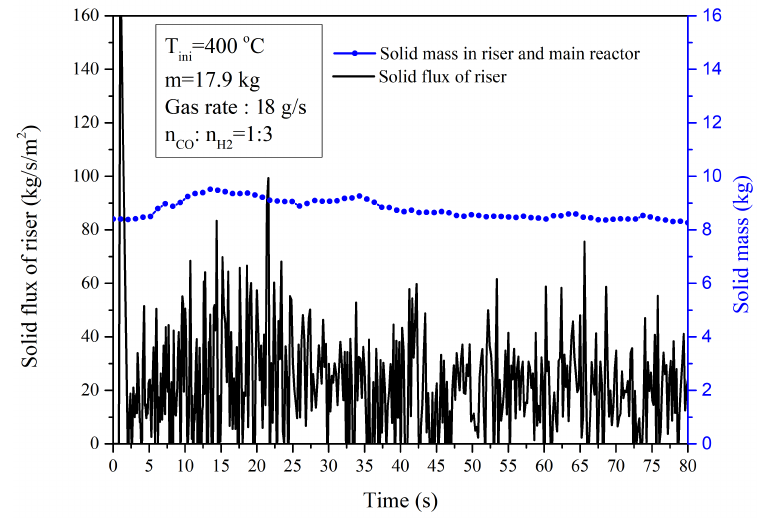
Figure 10. Time-evolution of solid flux of riser. Initial temperature is 400 ◦ C. Gas inlet rate is 1.8 g/s. Solid inventory is 17.9 kg.